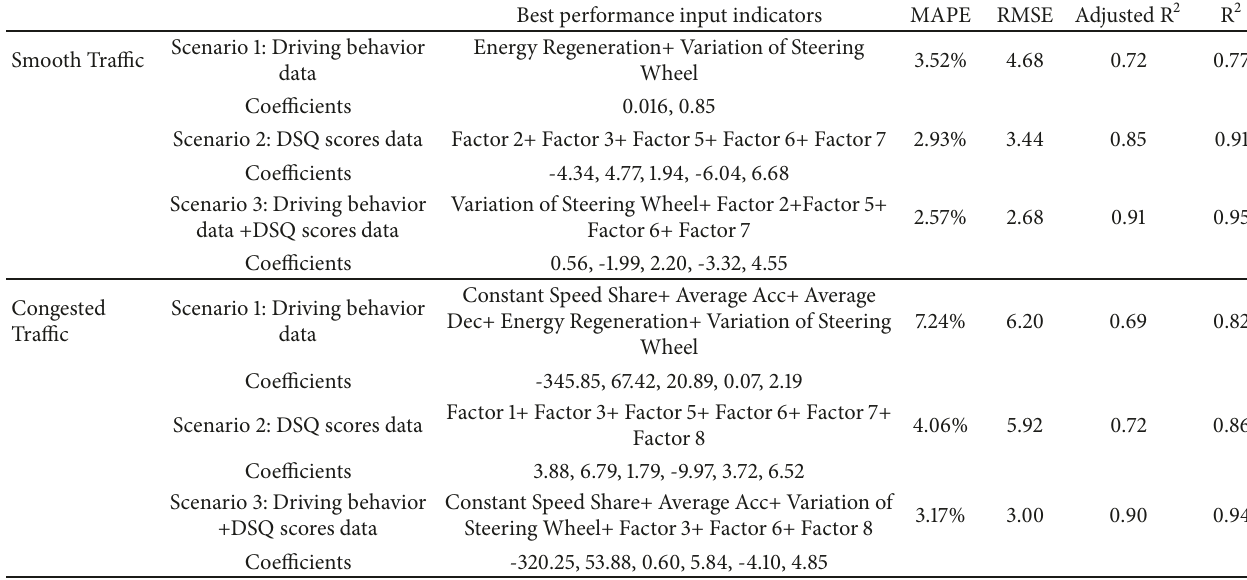
Table 5: Performance of regression